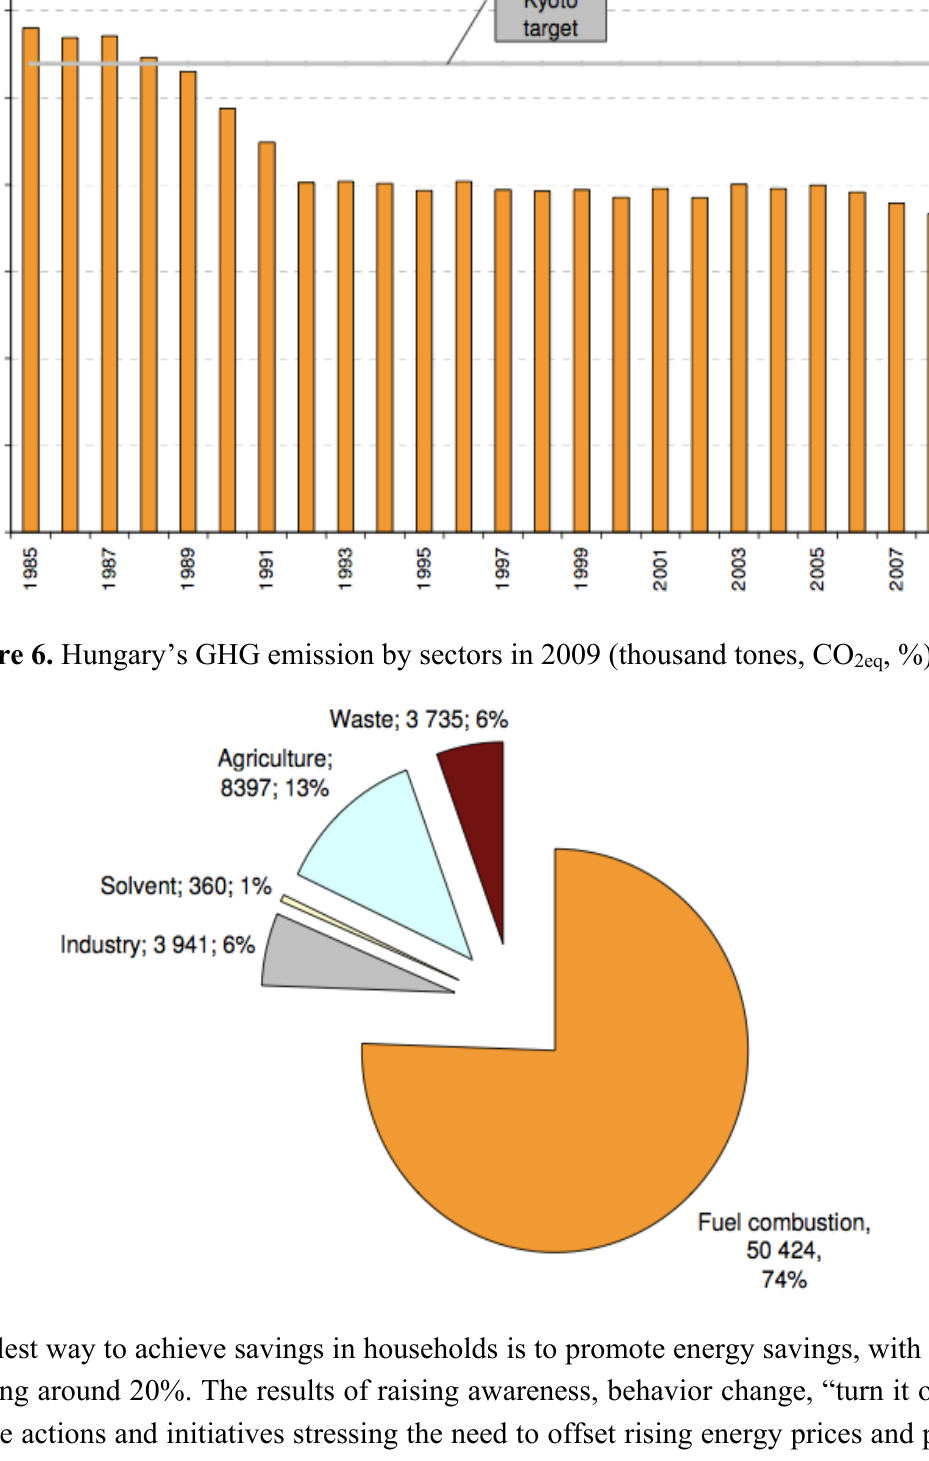
Figure 5. Hungary’s GHG reduction 1985–2005 (excluding LULUCF) [52].